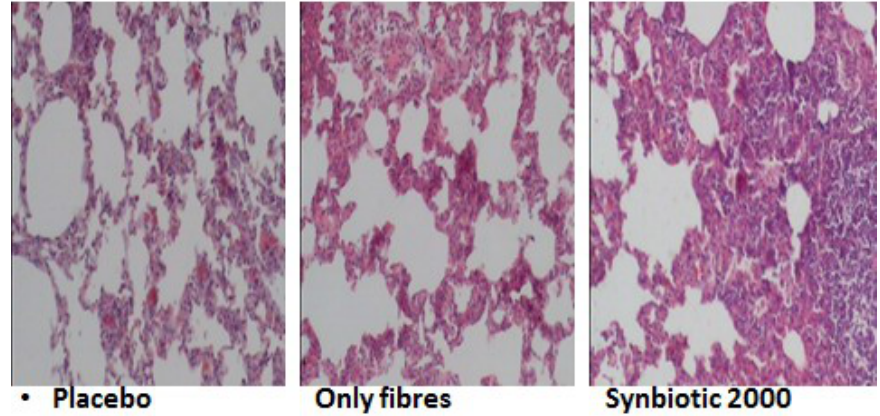
Figure 1. Hematoxylin-eosin of lung tissues from placebo, only fibers-treated and Synbiotic 2000-treated animals [71].